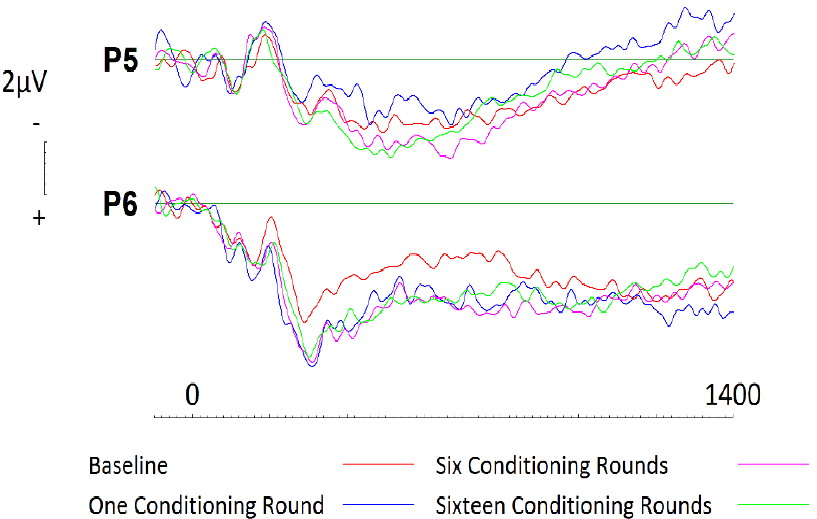
Figure 6. ERPs generated during each conditioning round for liked brands across parietal electrode sites P5 and P6. A significant increase in activity is apparent between baseline recording and subsequent sessions at parietal site P6 only.